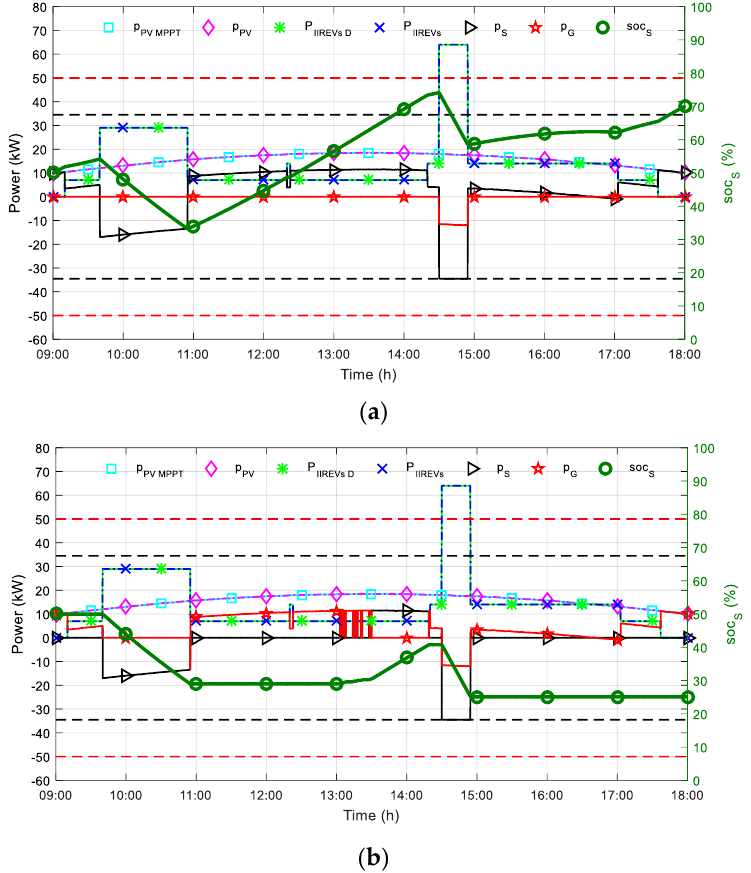
Figure 6. Power flow and storage state of charge in ( a ) “Sim w/o opt” and ( b ) “Sim with opt”—case 1.